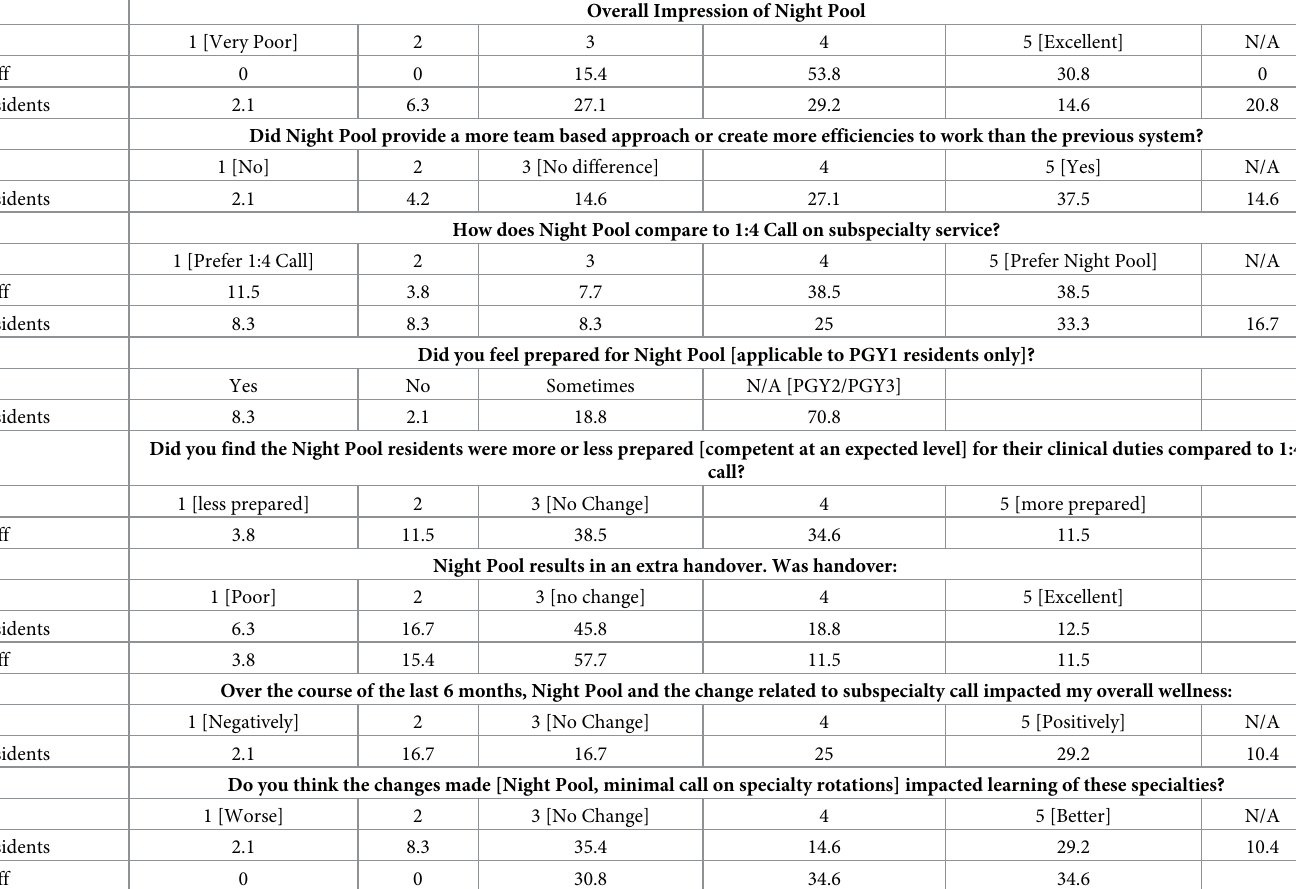
Overall Impression of Night